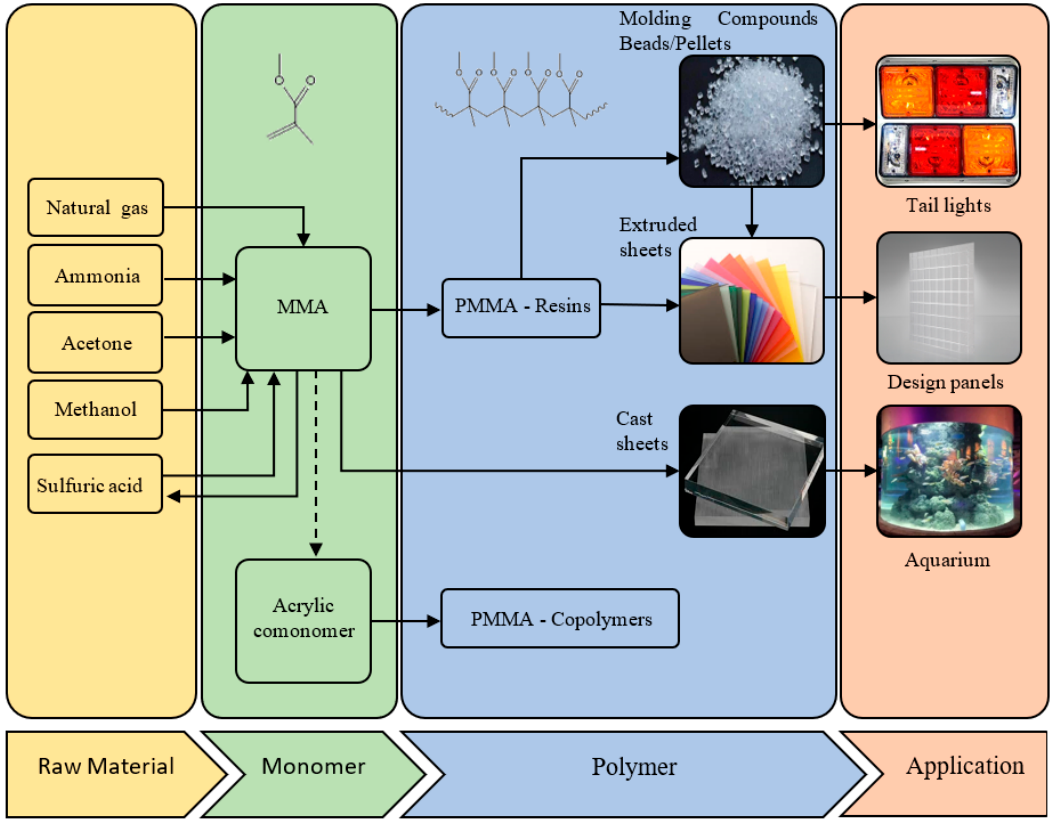
Figure 2. Overview of the synthesis of poly(methyl acrylate) (PMMA); starting from raw material and its applications based on the work of the Methacrylate Sector Group [40] .